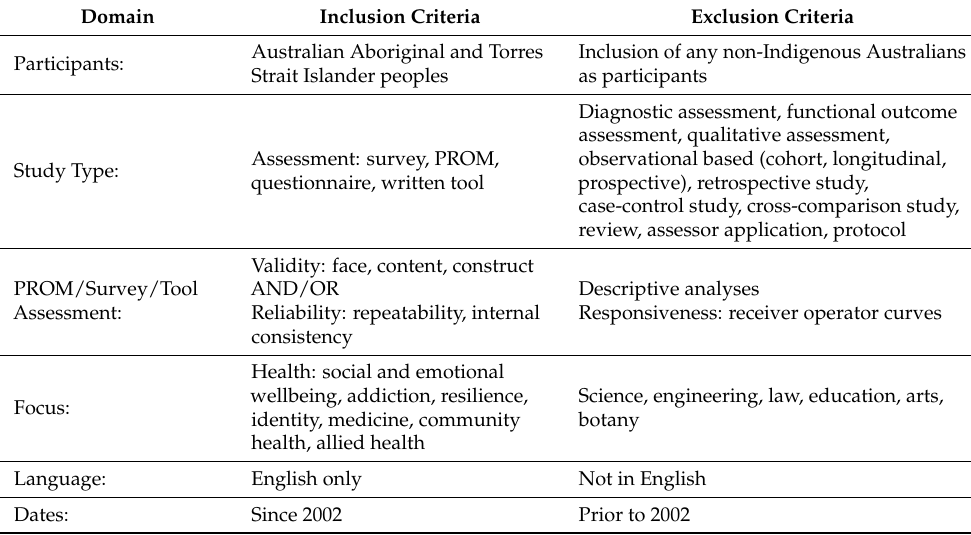
Table 2. Selection of sources of